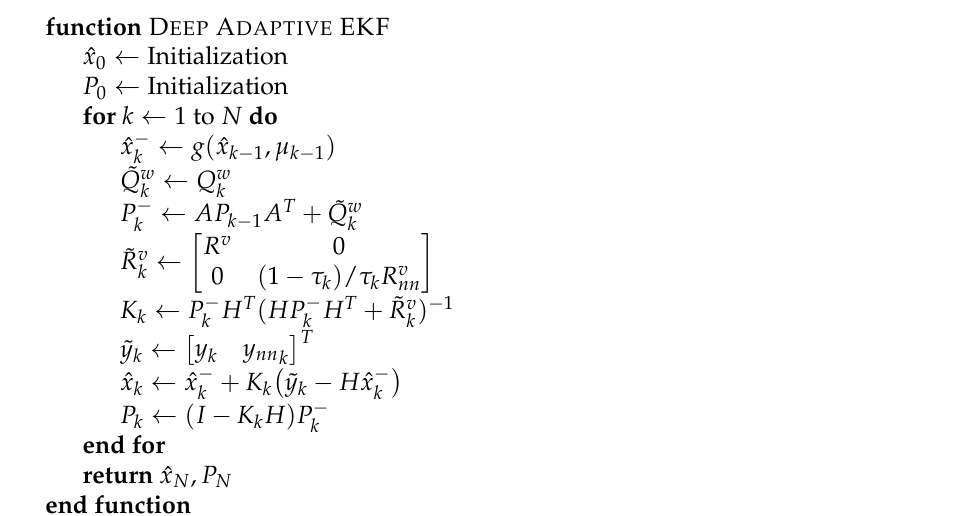
The architecture of AEKF. Figure 4. ::: :::::::::: :: ::::: Algorithm 1 Transformer Aided Adaptive Extended Kalman